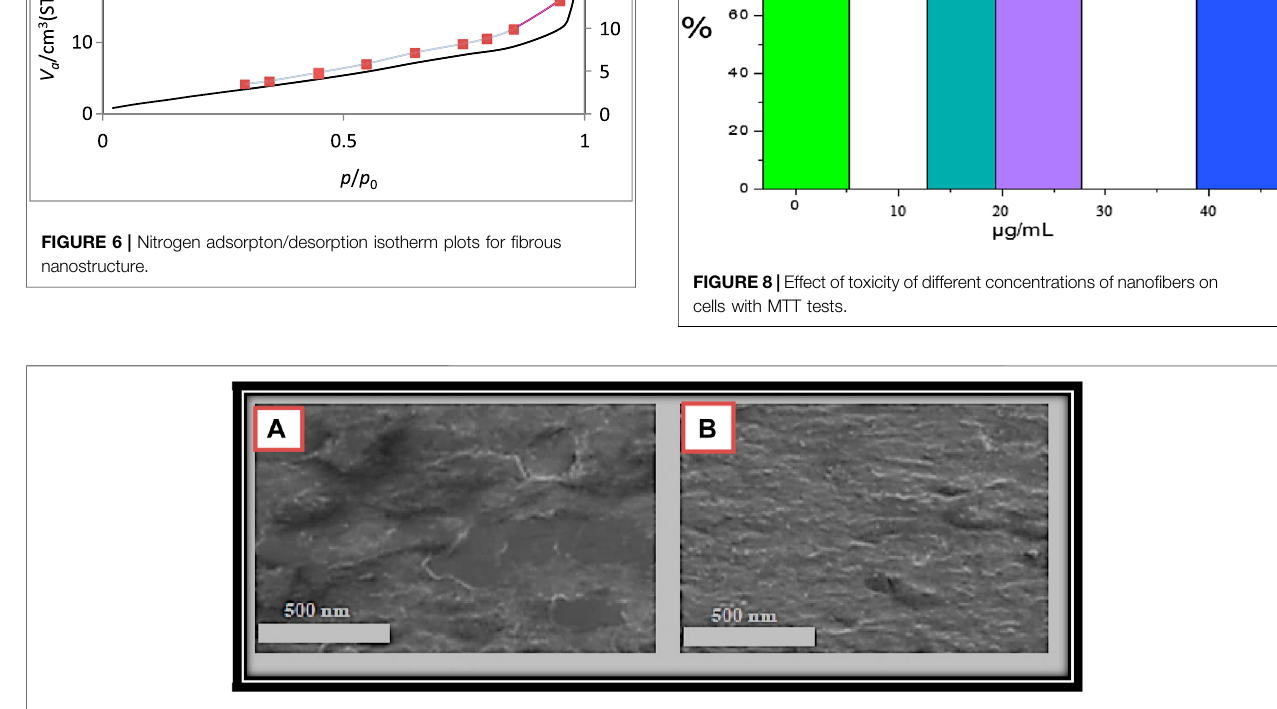
FIGURE 7 | SEM image for the egg shell before (A) and after (B) abrasion test.